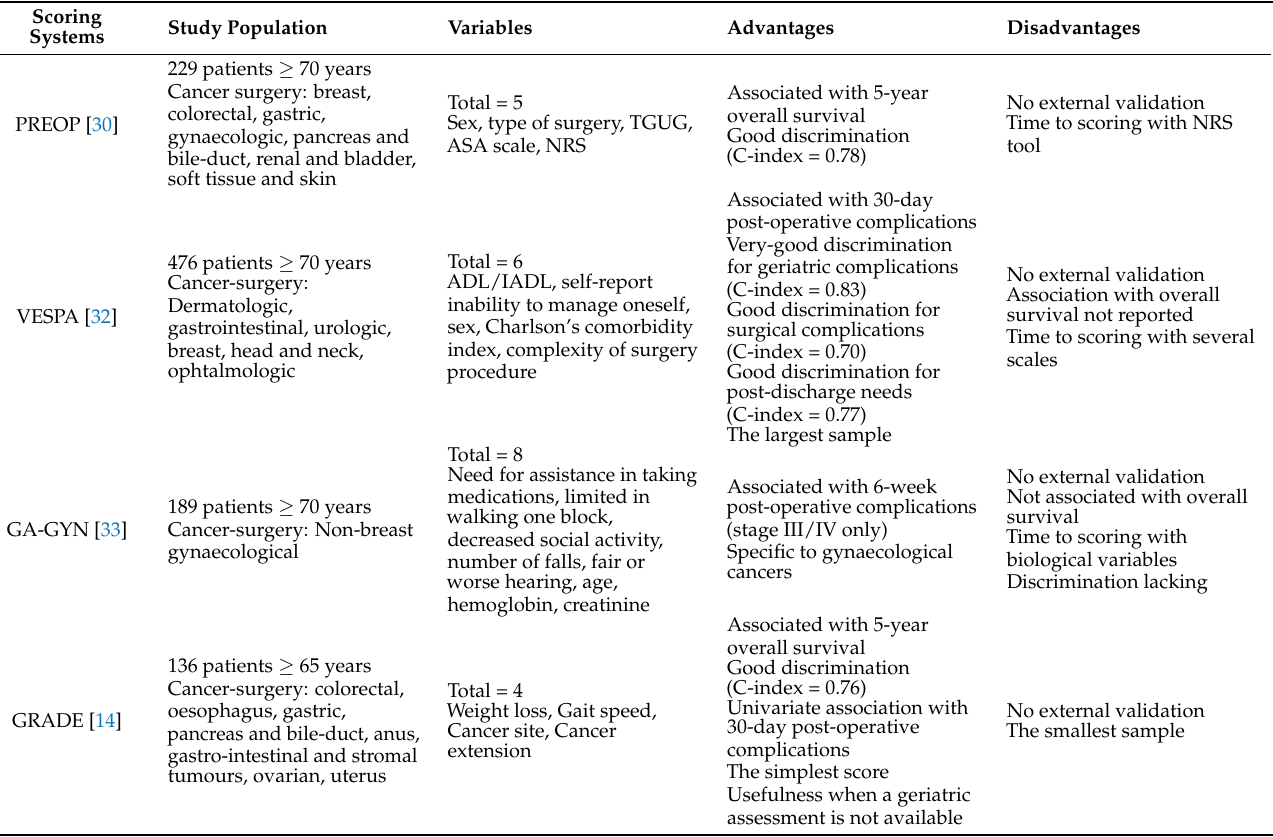
Table A2. Comparison of pre-operative scoring systems among older adults referred for a cancer-